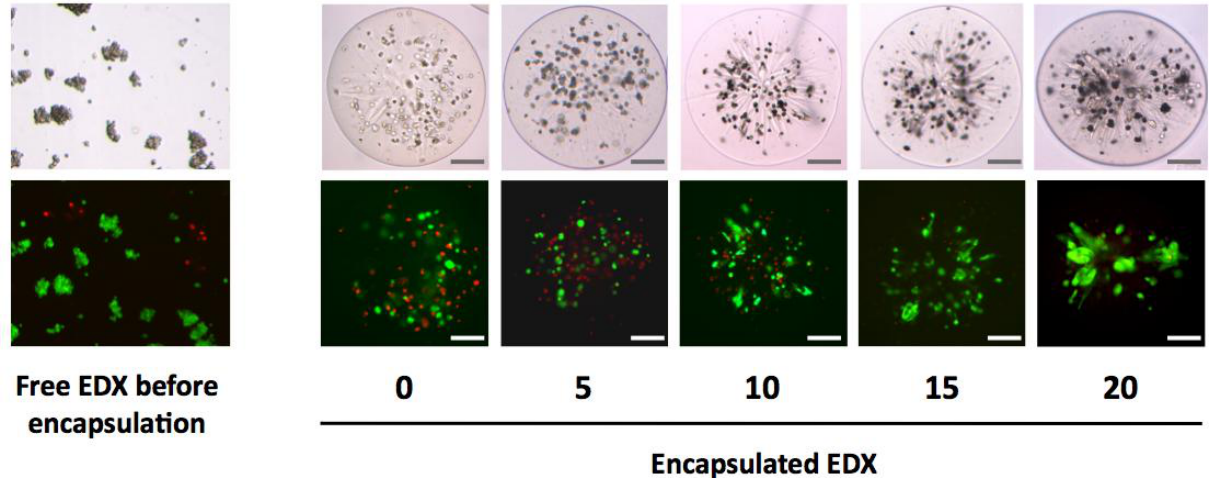
Figure 4. Microphotographs of non-encapsulated (left panel) and microencapsulated primary human foreskin fibroblasts (EDX cells) (right panel), visualization of representative examples at different time points (in days) up to 20 days after microencapsulation. Top, light microscopy; bottom, viability staining of the same objects with fluorescein diacetate (green: living cells) and propidium iodide (red: dead cells). The average diameter of the microspheres was 550 µm. Scale bars: 100